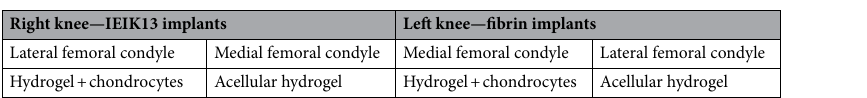
Table 1. Distribution of hydrogel implants according to anatomical sites of the joints. The table is representative of two knees of the same animal.